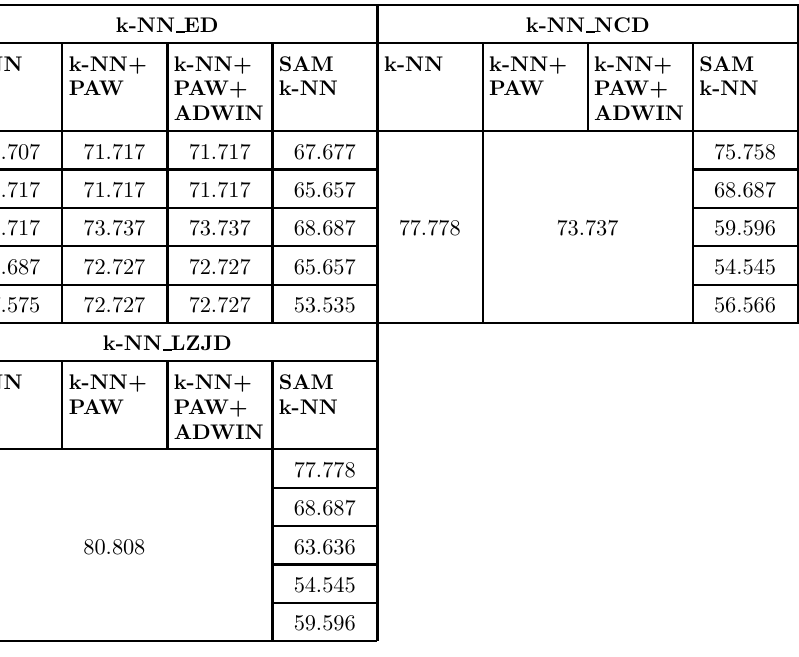
Table 1. K-nearest neighbour classification using Euclidean distance, Normalized Compression Distance and Lempel-Ziv Jaccard Distance for the measurements taken from the first patient k-NN ED k-NN